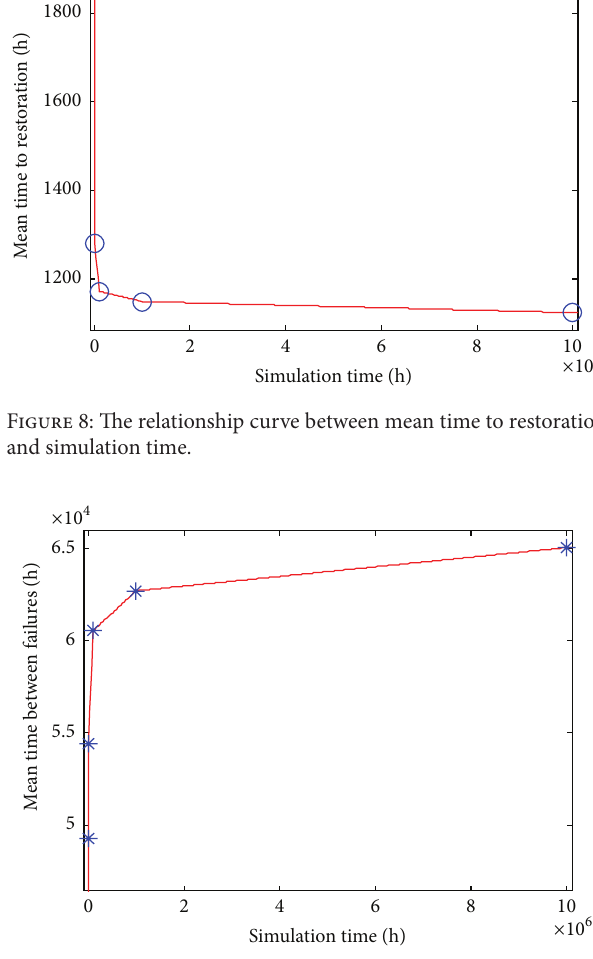
Figure 9: The relationship curve between mean time between failures and simulation